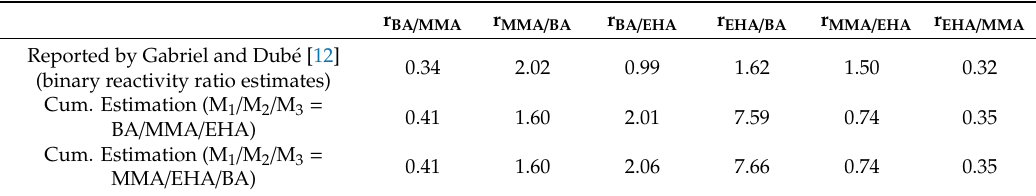
Table 5. Reactivity ratio estimates for the terpolymerization of BA / MMA / EHA from all terpolymerization data (experimental data from [12]). r BA / MMA r MMA / BA r BA / EHA r EHA / BA r MMA / EHA r EHA /